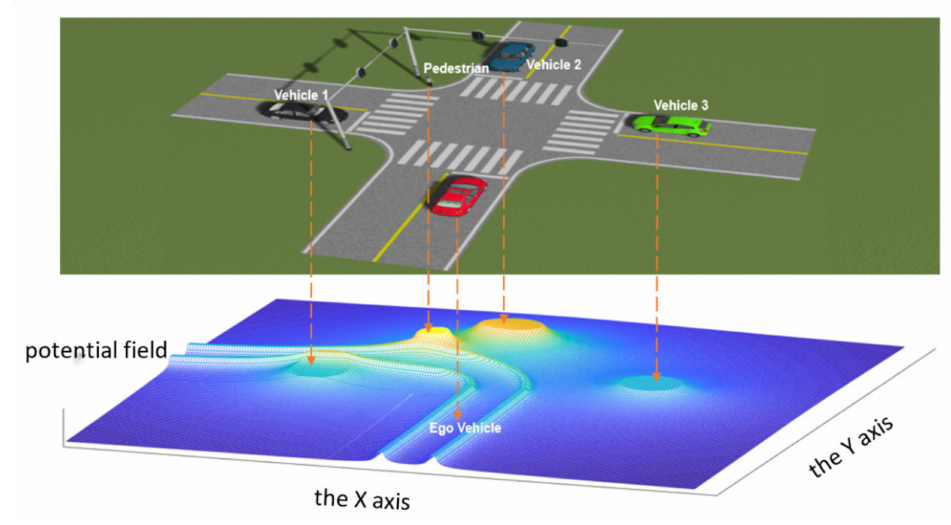
Figure 6. The potential field of the environmental elements at intersection with traffic signal.